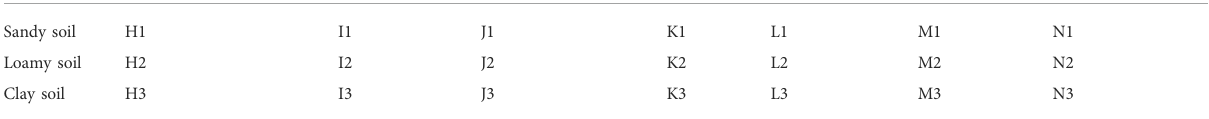
TABLE 4 Experimental design of glycine on petroleum hydrocarbons degradation in soil under different soil conditions. Treatment Natural degradation White clover White clover + G Ryegrass Ryegrass + G Sudan grass Sudan grass + G Sandy soil H1 Loamy soil